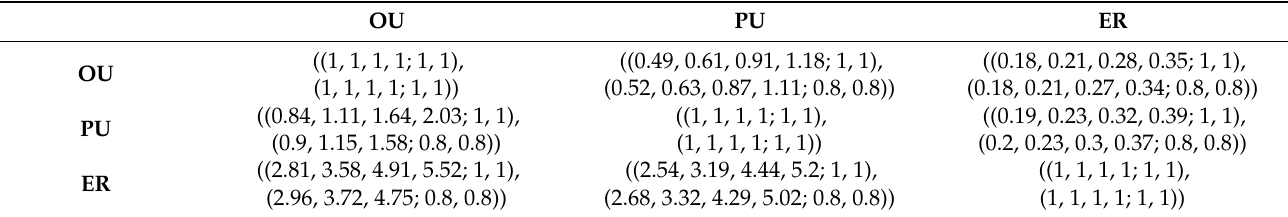
Table 4. Pairwise IT2F comparison matrix—Effectiveness factors.